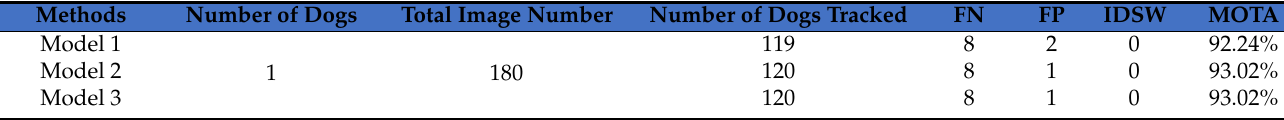
Table 13. Results of dog-tracking experiments conducted using IMG_0041_1 data-set.